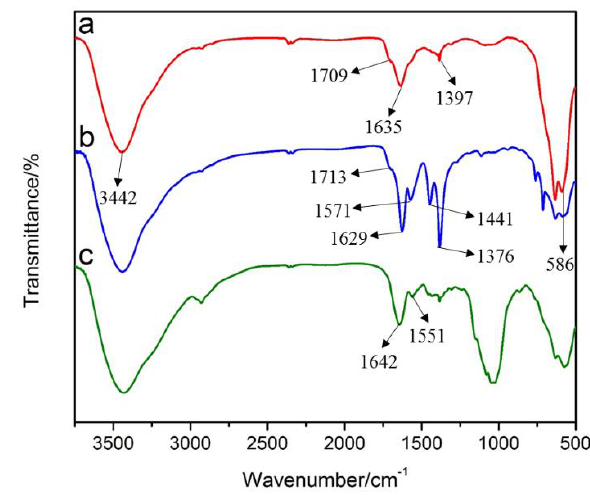
Figure 2. FT-IR spectra of Fe 3 O 4 microsphere ( a ), Fe 3 O 4 @MIL-100 (Fe) support ( b ) and the immobilized lipase ( c ).